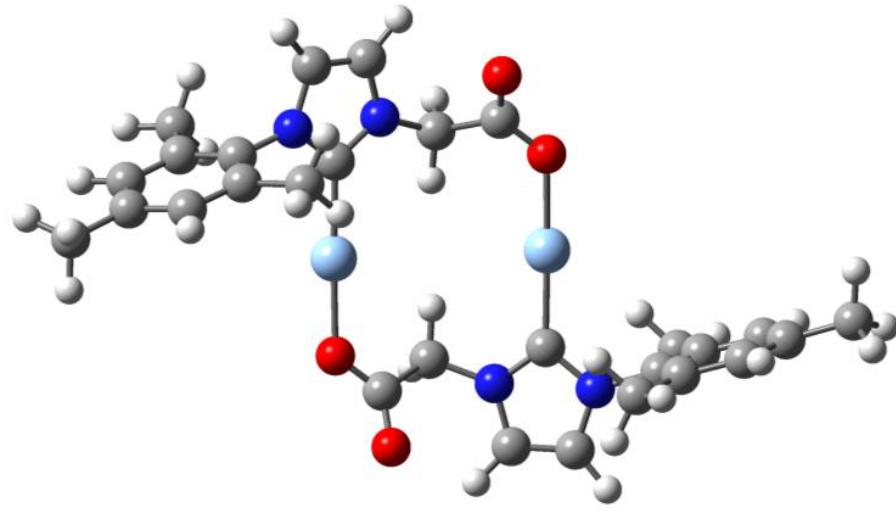
Figure 3. Optimised structure of the dimeric model 2a c .